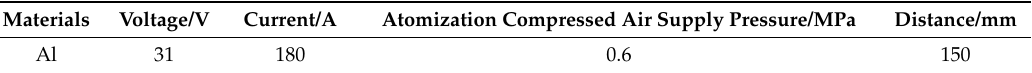
Table 2. Arc spraying